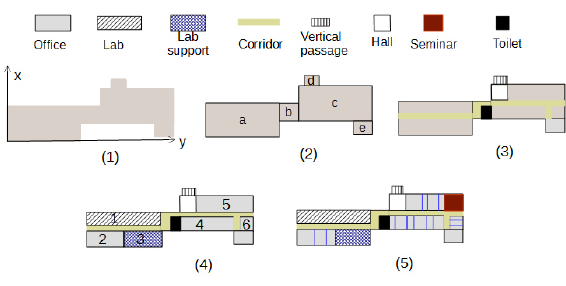
Figure 19. An example of mapping process with grammars Reconstructed map closely approximates the ground